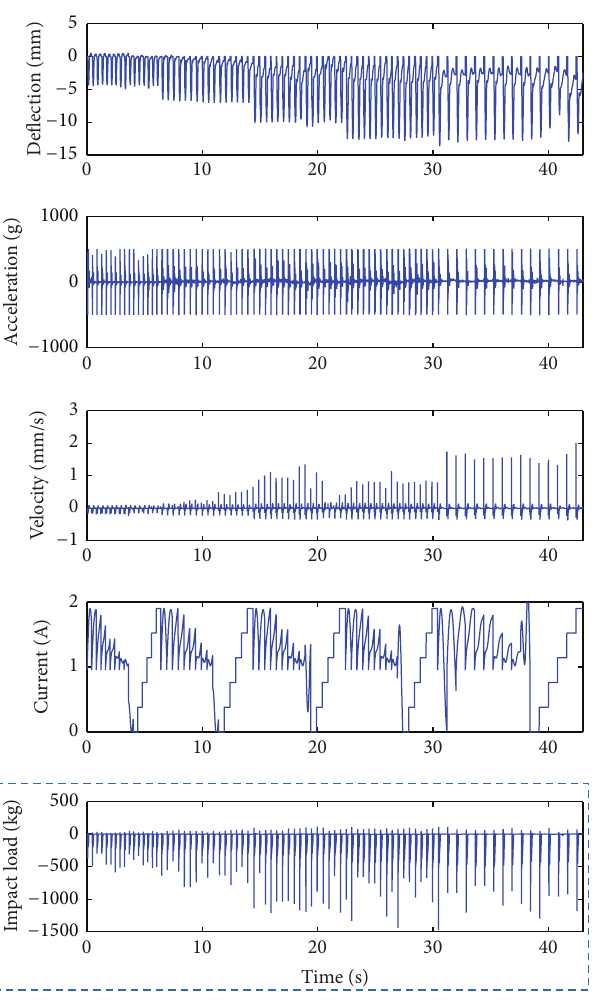
Figure 11: Input-output data sets to test the neurofuzzy models.